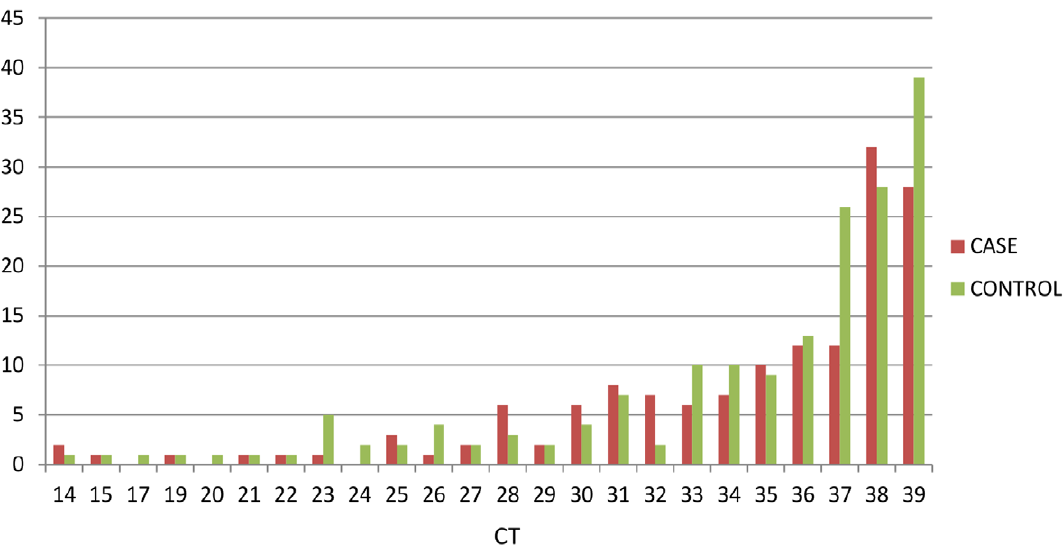
Figure 1. HBoV detection assays, CT distribution in cases and controls. doi:10.1371/journal.pone.0041346.g001 PLoS ONE |